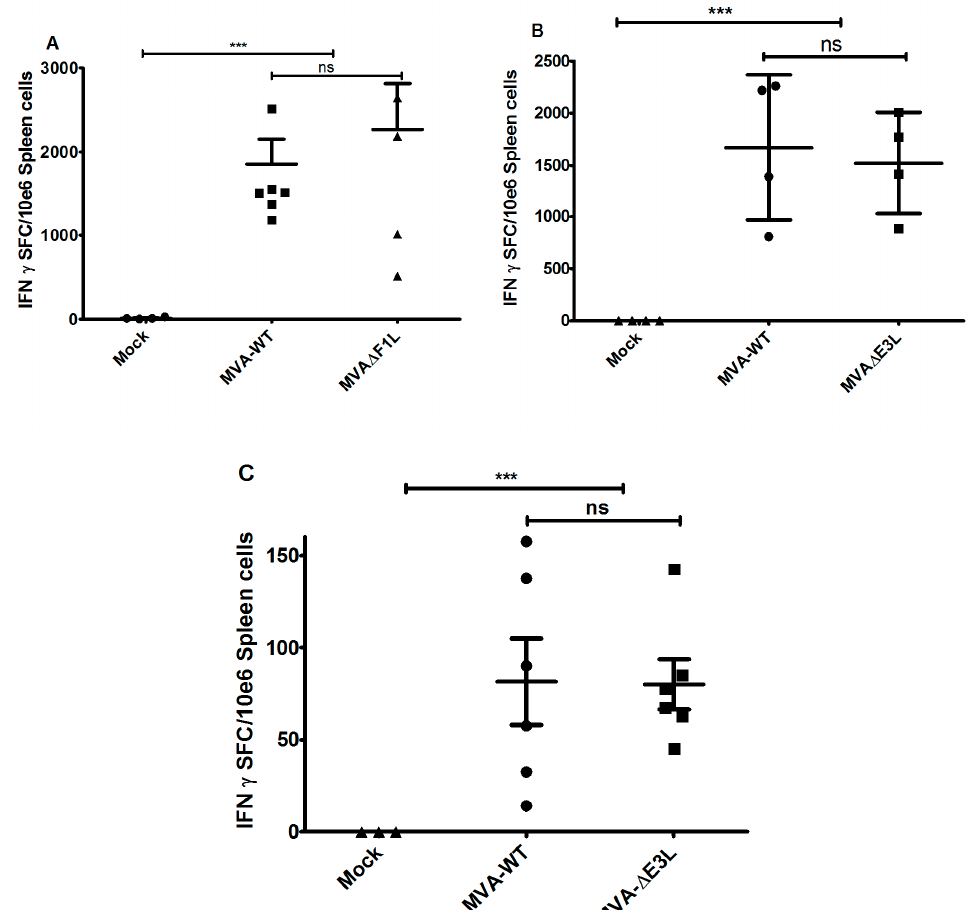
Figure 3. Virus-specific CD8+ T cells elicited by MVA vaccination. C57BL/6 mice were inoculated